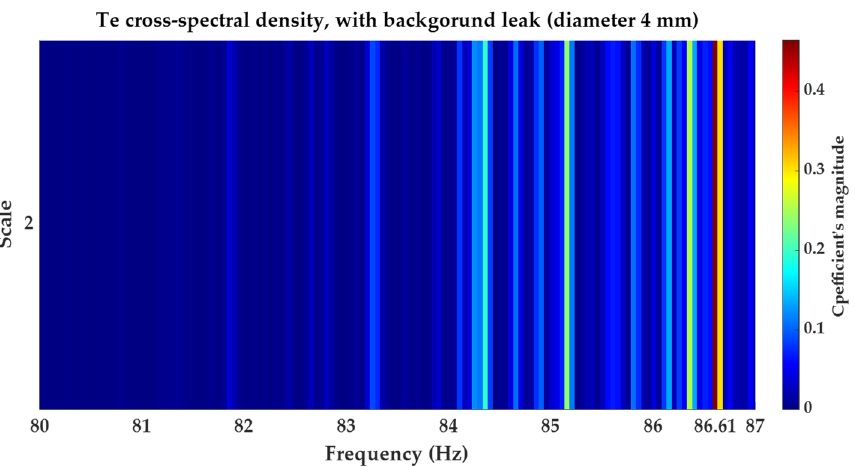
Figure 20. 𝒯 (cid:3032) cross-spectral density in Scale 2 , with background leak ( 4 mm in diameter) and flow rate 125.0 mL/s .